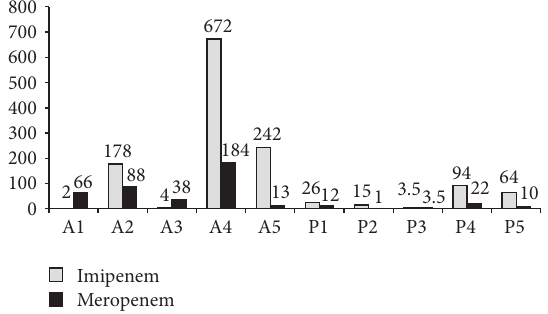
Figure 1: Mutant Selection Window for 5 Acinetobacter baumannii and 5 Pseudomonas spp. strains using Imipenem and